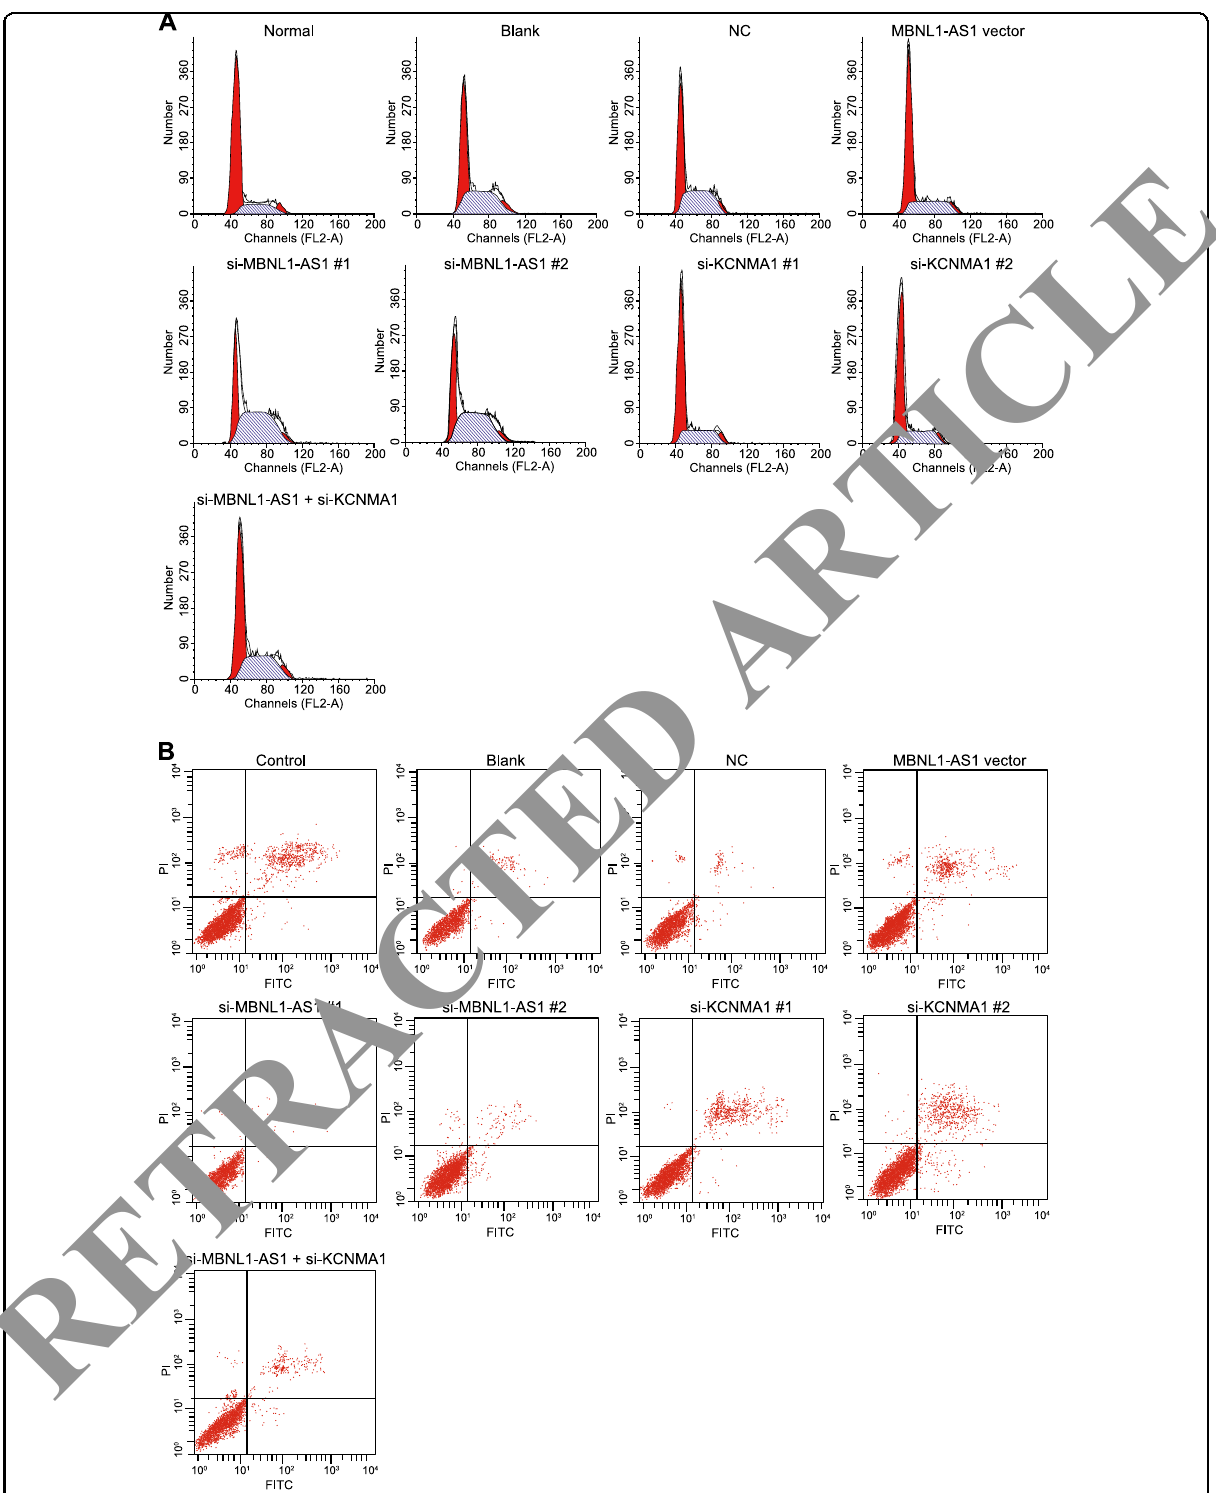
Fig. 9 Flow cytometry showed that MBNL1-AS1 promoted the apoptosis of skeletal muscle cells. a Cell cycle of skeletal muscle cells in seven groups as detected by fl ow cytometry. b Apoptosis of skeletal muscle cells in seven groups as detected by fl ow cytometry. MBNL1-AS1 muscleblind- like 1 antisense RNA 1, KCNMA1 potassium calcium-activated channel subfamily M alpha 1, si small interfering, NC negative control; * p < 0.05 vs. the control group; # p < 0.05 vs. the blank and NC groups; measurement data are expressed as the mean ± standard deviation. Comparisons among multiple groups were performed by one-way ANOVA; the experiment was repeated 3 times Of fi cial journal of the Korean Society for Biochemistry and Molecular